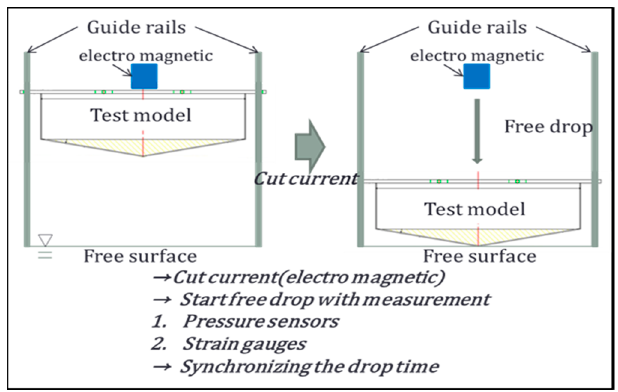
Figure 4. Slamming experimental test set-up condition.